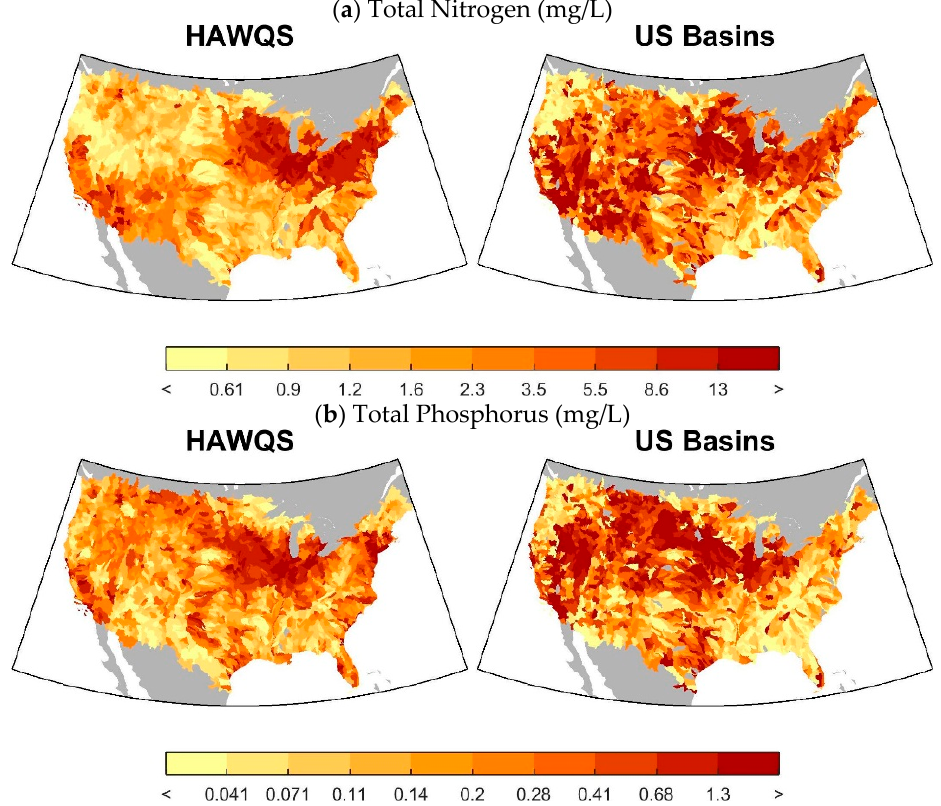
Figure 4. Mean baseline nitrogen ( a ) and phosphorus ( b ) concentrations (mg/L), 1986–2005, at the HUC-8 watershed scale for US Basins and HAWQS3.2. Climate change impacts and effect of greenhouse gas (GHG) mitigation on water quality.